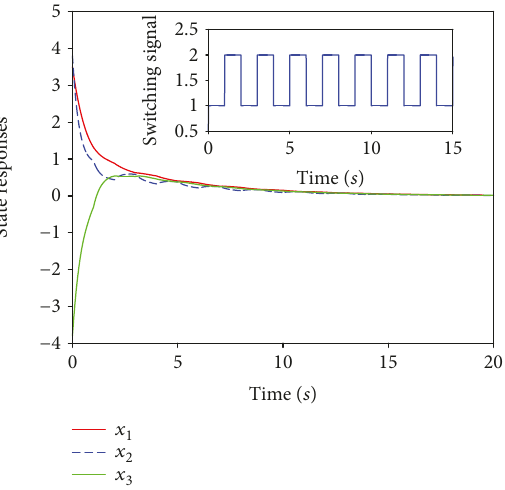
Figure 2: State responses of subnetwork 2 of the considered SNNs for Example 1 with the initial condition ψ s = − cos s ; cos s ; − tanh s − 0 2 T